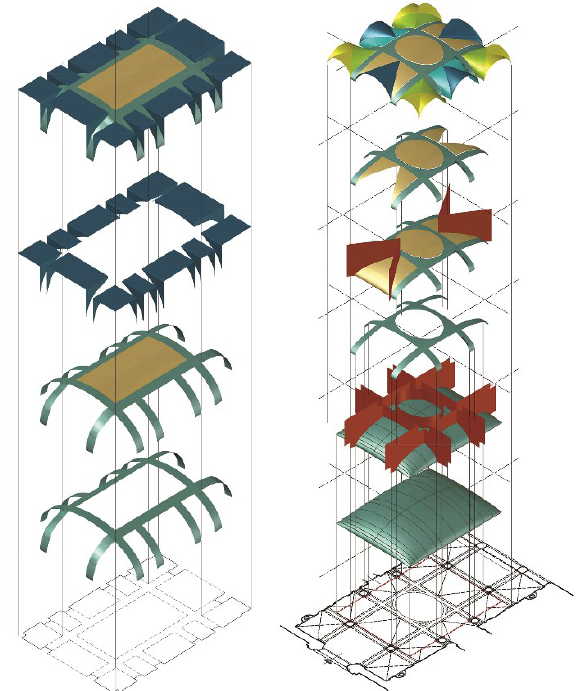
Figure 5. Decomposition method for banded vaults with independent arches (left) and with arches belonging to the main surface (right). Modelling: R. Spallone, M. Vitali